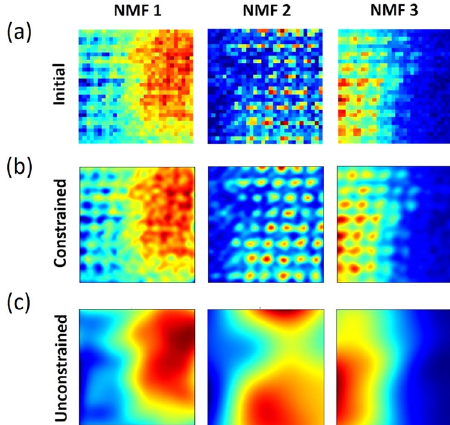
Fig. 2 Independent GP reconstruction of the fi rst three NMF component maps with constrained and unconstrained kernels. For clarity, analysis is performed on a 30 × 30 subset of the image. Shown are initial NMF components (top row), constrained GP (higher kernel length limit = 3), and unconstrained reconstructions (bottom row). The resampling is 4 times denser than the initial